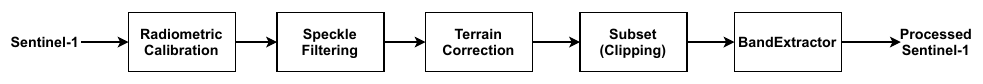
Figure 3. Processing pipeline for Sentinel-1. The suggested framework implements this pipeline using the Graph Processing Tool (GPT) of the ESA SNAP